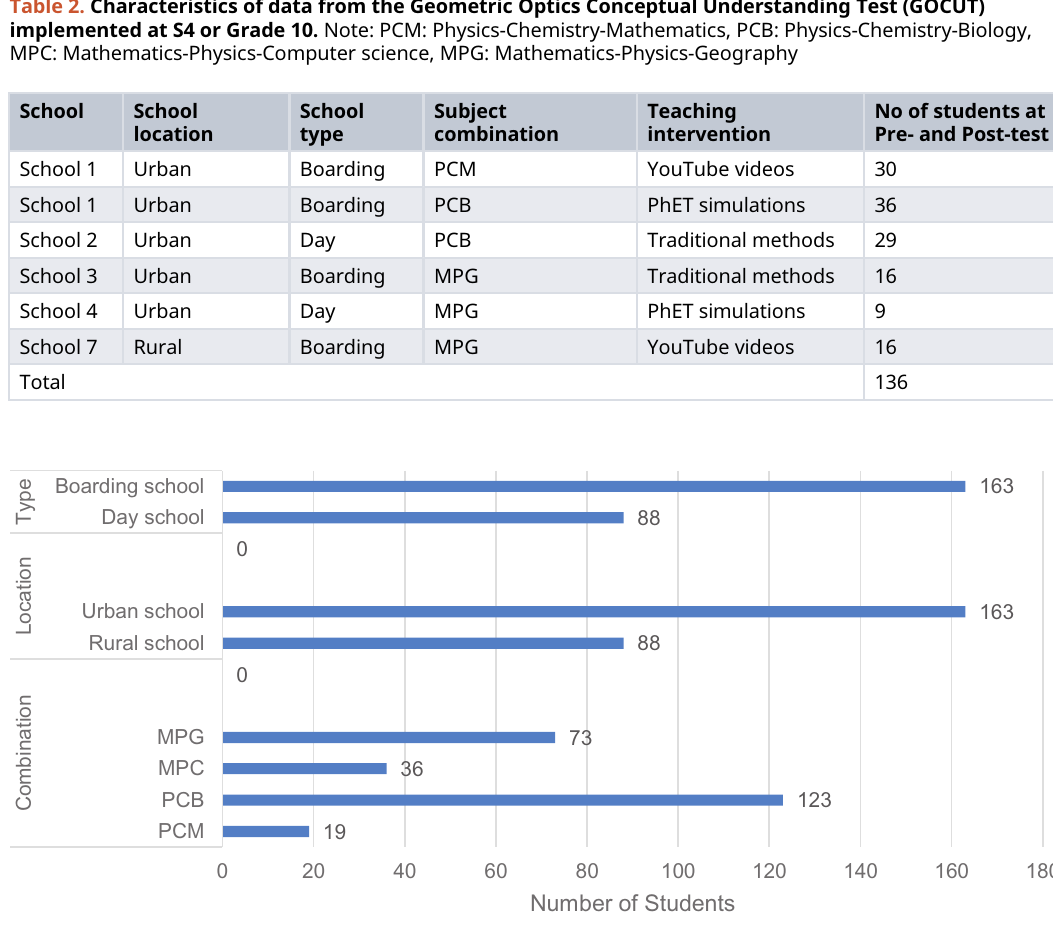
Figure 1. Number of students who carried out the Light Phenomena Conceptual Assessment (LPCA), accord- ing to type and location of school, and subject combination characteristics. PCB: Physics-Chemistry-Biology, MPG: Mathematics-Physics-Geography, PCM: Physics-Chemistry-Mathematics, MPC: